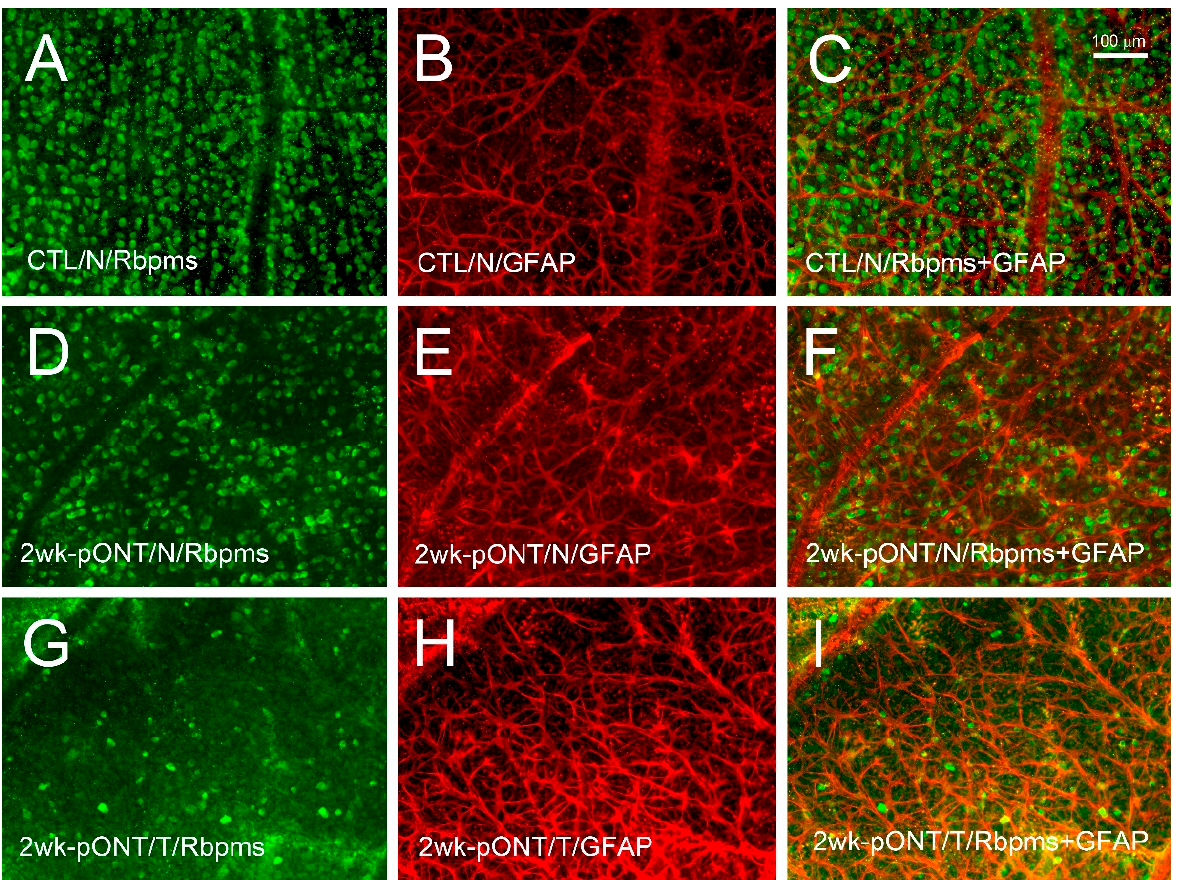
Figure 1. Loss of RGCs and glial reactivity two weeks after pONT. Double immunohistochemistry of RBPMS and GFAP was performed on retinal wholemounts. Compared to the contralateral control ( A – C ), noticeable dropout of RGCs was detected and reactive astrocytes were present in the nasal quadrant after pONT ( D – F ). A more dramatic loss of RGCs and increased astrocytic reactivity were noted in the temporal quadrant after pONT ( G – I ). N = nasal; T = temporal; RBPMS = RNA binding protein with multiple splicing; GFAP = glial fibrillary acidic protein; 2 wk = 2 weeks; pONT = partial optic nerve transection; CTL = control.